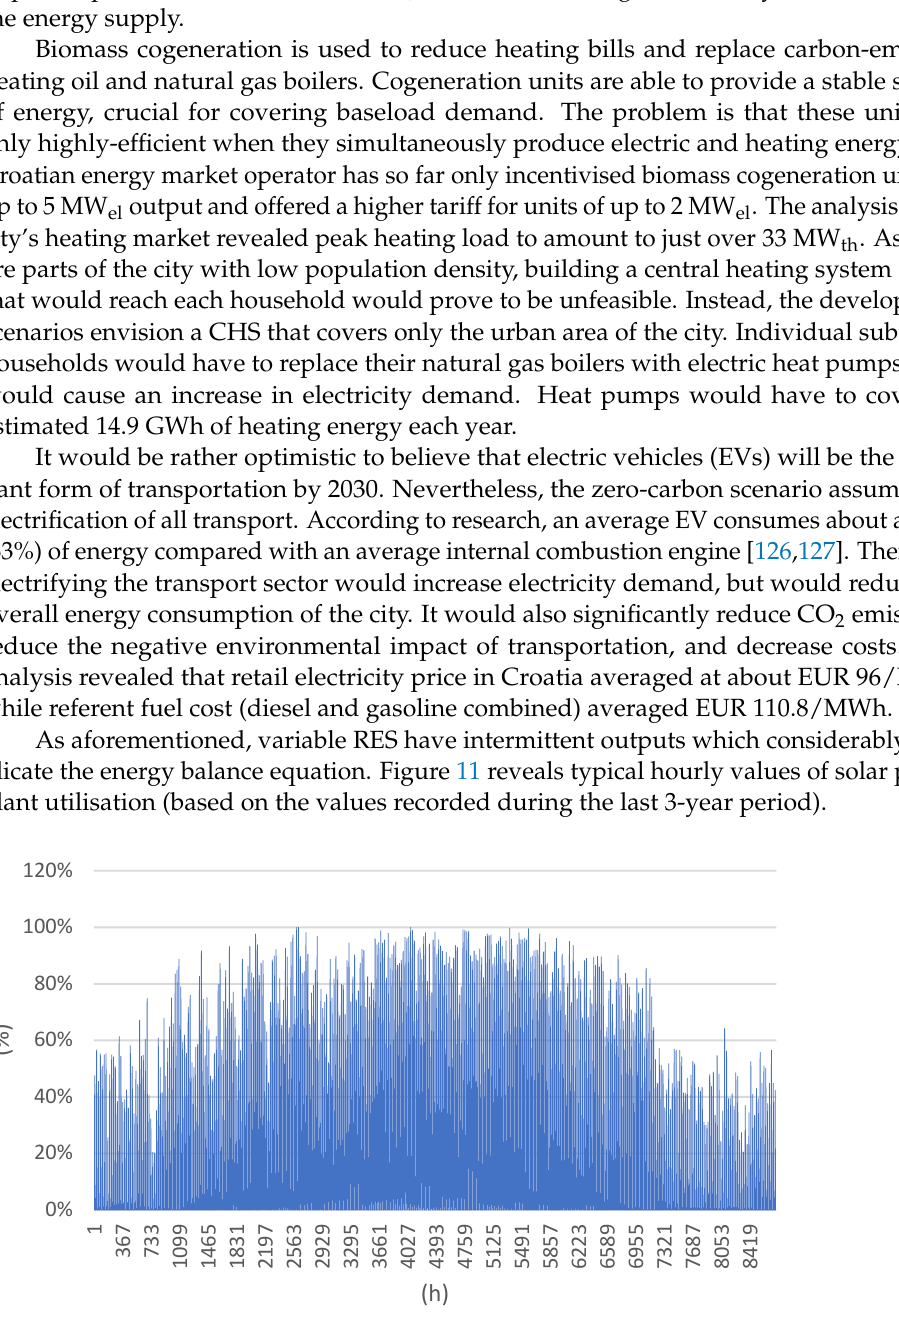
Figure 12. Average weekly production of the Croatian hydro sector. Effective market analysis requires hourly load profiles to be compared with the in- termittent output of the assumed generation portfolio. An optimisation procedure is run for each of the twelve scenarios defined in the previous chapter. Only the main findings are outlined. To provide a better understanding of the output results, Figure 13 reveals the balance during a week-long period of the referent scenario 2 (R2).